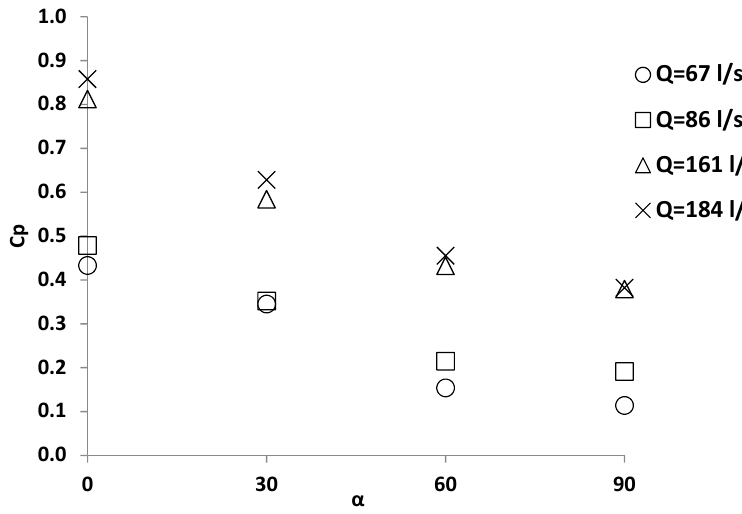
Figure 6. Mean dynamic pressure coefficient versus angle of impact plate.